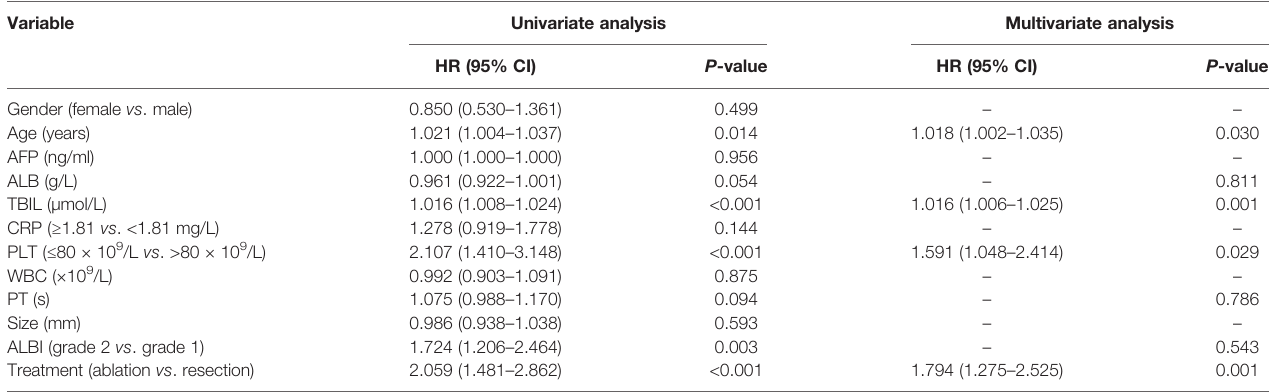
TABLE 6 | Univariate and multivariate analyses of recurrence-free survival (RFS) in the entire